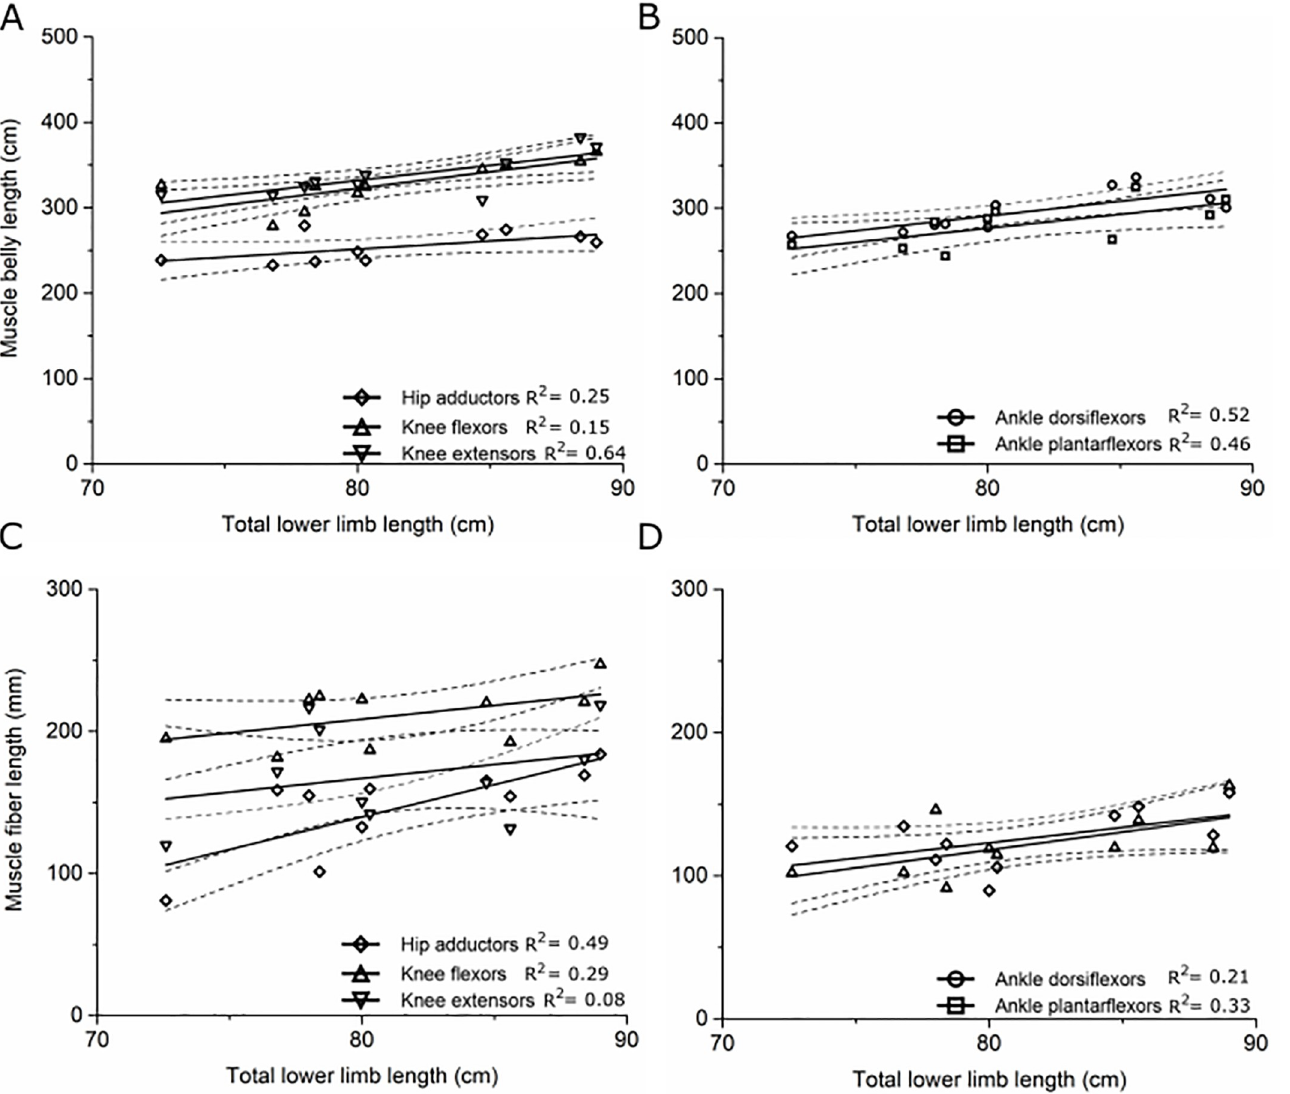
Fig 3. The scaling relationships between: Individual limb length and muscle belly length in the (A) hip adductors, knee flexors and knee extensors; (B) ankle dorsiflexors and ankle plantarflexors; and muscle fiber length in the (C) hip adductors, knee flexors and knee extensors; (D) ankle dorsiflexors and ankle plantarflexors. Dotted lines represent ± 1 standard error